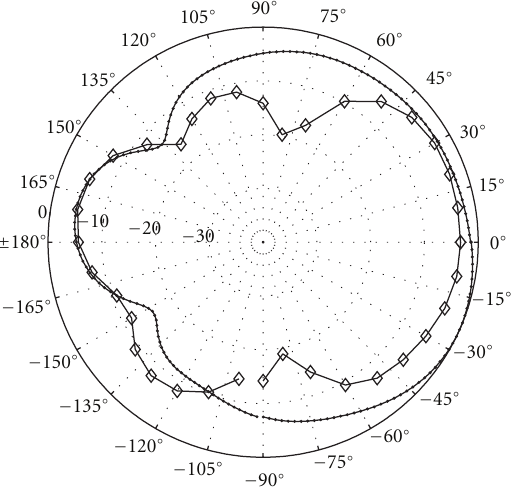
Figure 6: Normalized simulated directivity pattern comparison for the antennas without ground plane—dotted markers for V-shaped and diamond markers for Yagi pattern.